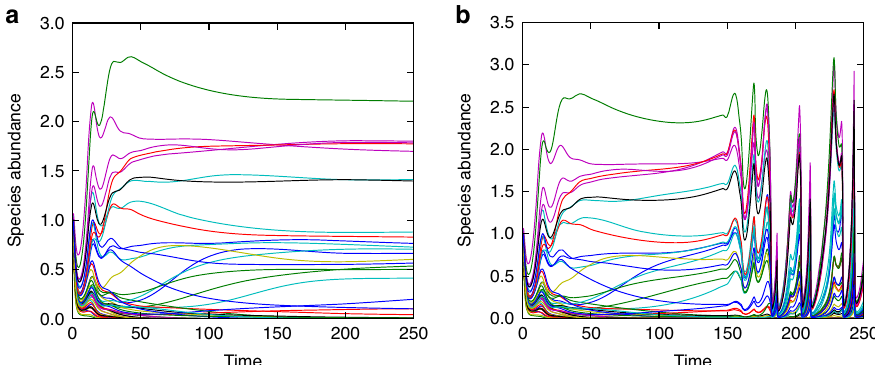
Fig. 5 Dispersal can induce instability of feasible equilibria. The prey species abundances in the non-spatial Levin-Segel ecosystem in panel ( a ) converge to a stable feasible equilibrium. In panel b , we simulate the ecosystem with the same parameters as in ( a ) but allowing for dispersal in space. Volatile behaviour is found in the spatial ecosystem, even though the non-spatial system would approach a stable equilibrium.